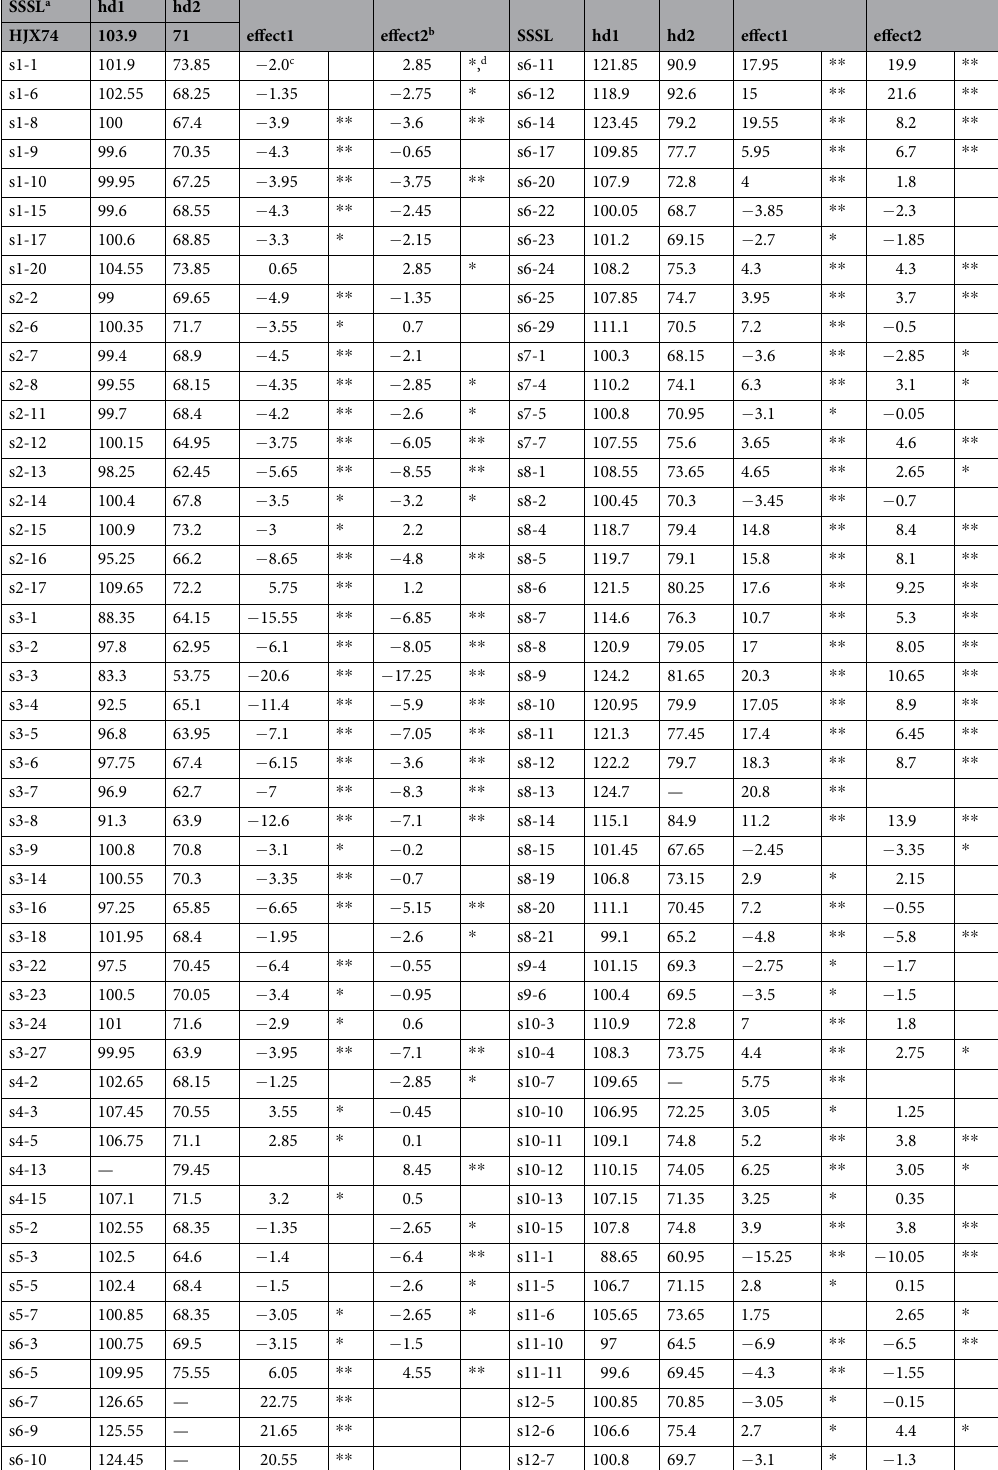
Table 2. Phenotypic and effect values (days) on heading date (hd) for Hua-jing-xian 74 (HJX74) and single segment substitution lines (SSSLs) with significant effects in the spring or the fall, respectively. a si-j represented jth SSSL on chromosome i . b hd1 and effect1, hd2 and effect2 indicated the phenotypic and effect values on HD for each SSSL in the spring and the fall, respectively. c The negative sign in the table indicated to shorten HD. d, * and ** showed the significance at the 0.05 and 0.01 levels,